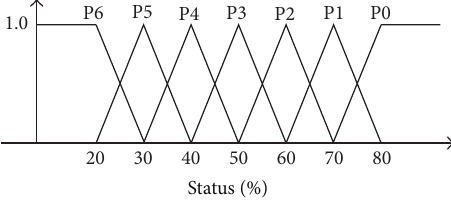
Figure 7: Triangular membership functions.